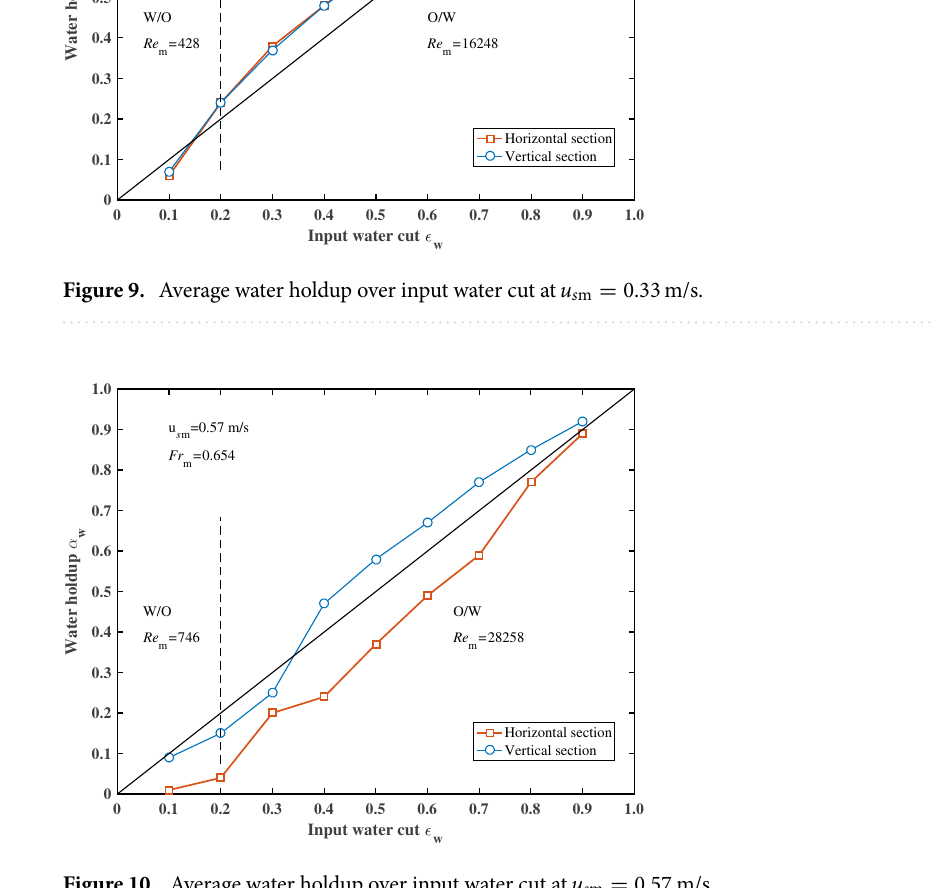
Figure 10. Average water holdup over input water cut at u s m = 0.57